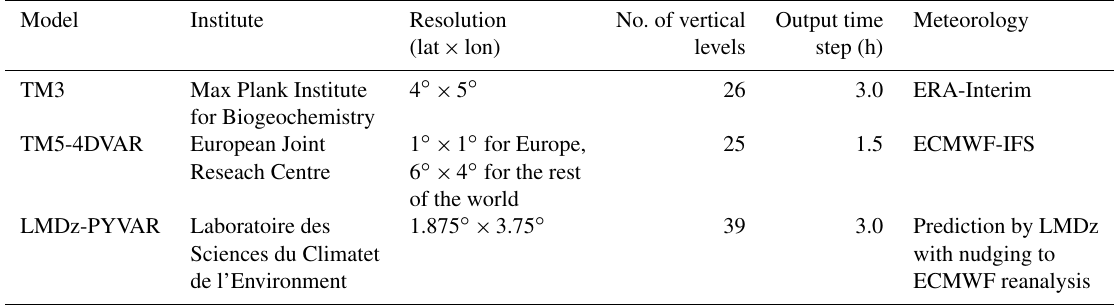
Table 2. Information on the models and set-up details. Model Institute Resolution No. of vertical Output time Meteorology (lat × lon) levels step (h) TM3 Max Plank Institute for Biogeochemistry TM5-4DVAR